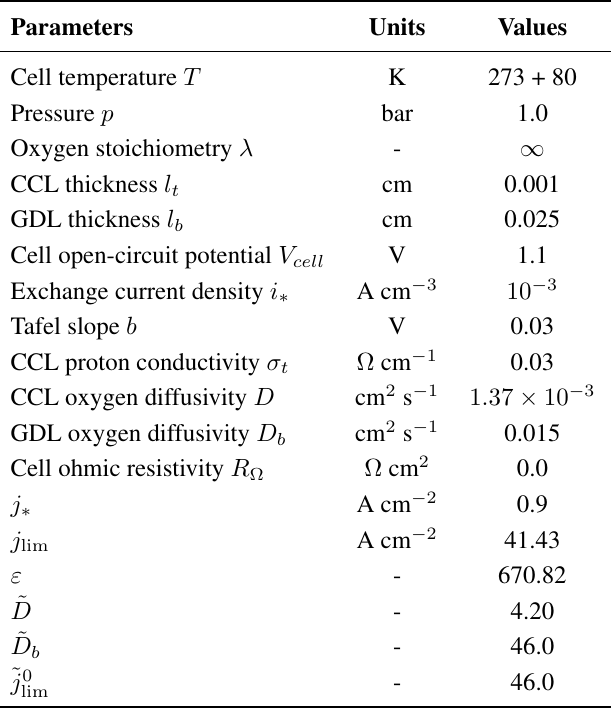
Table 1. The dimensional and respective dimensionless parameters of the “pristine”